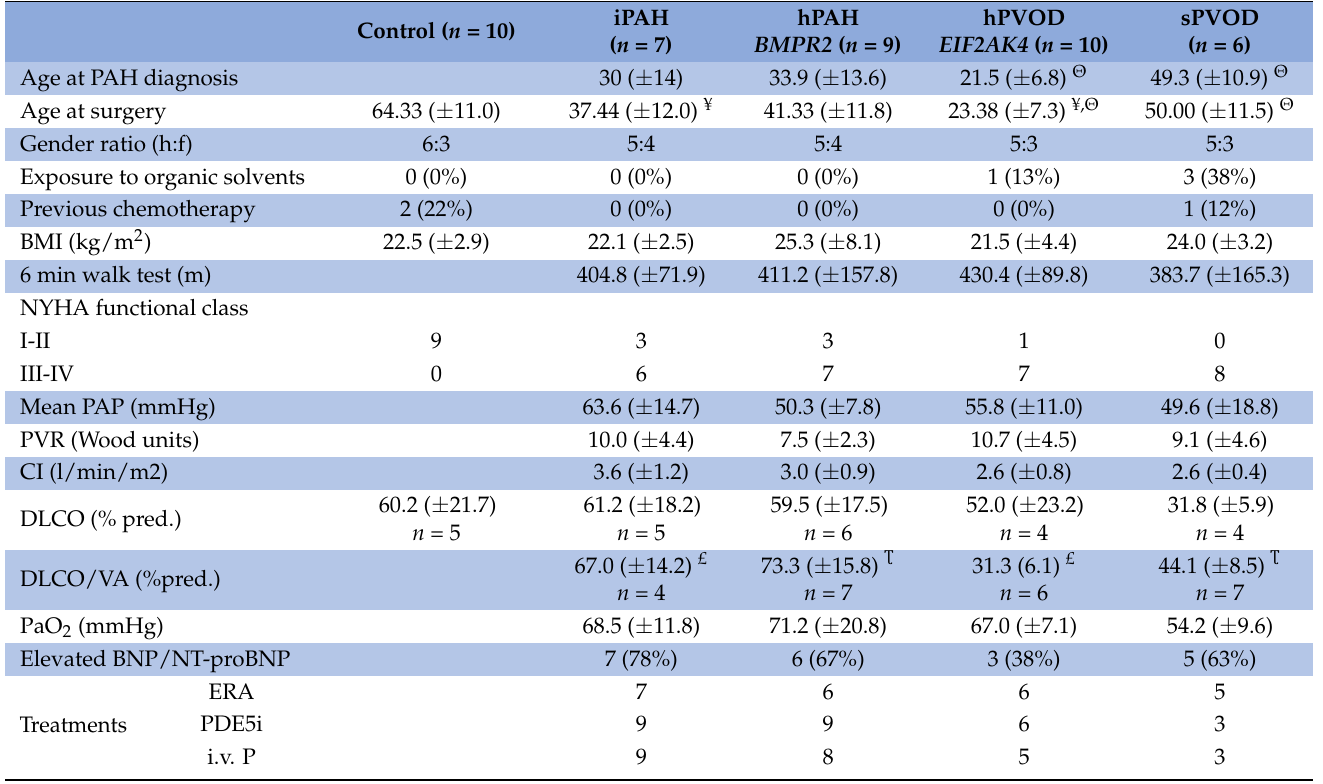
Table 1. Comparison of characteristics between patients of each group.